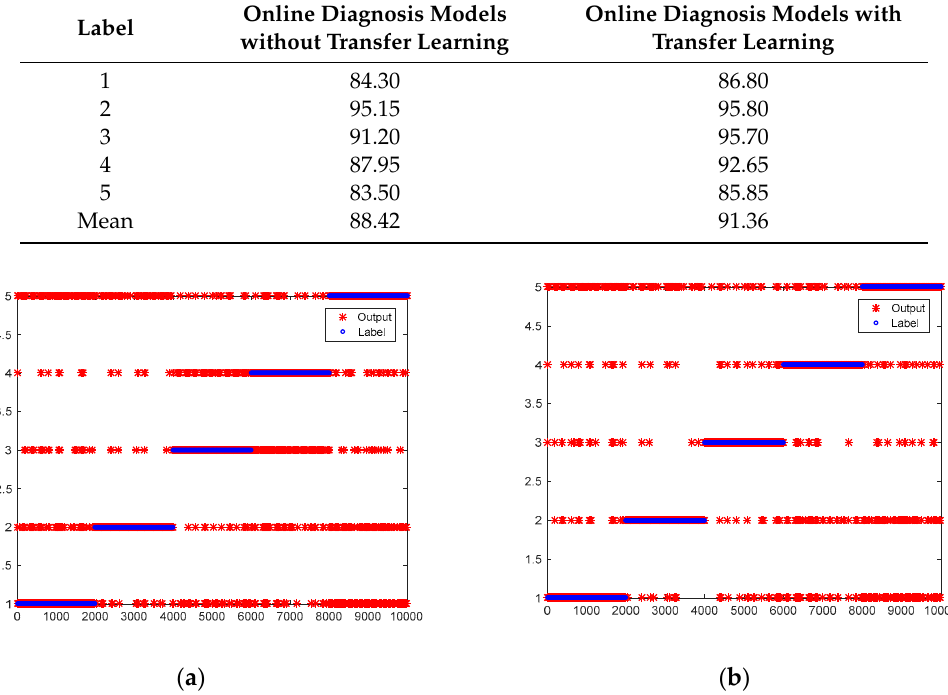
Table 11. The accuracy of online diagnosis of multi-rate sampling data without and with transfer learning.